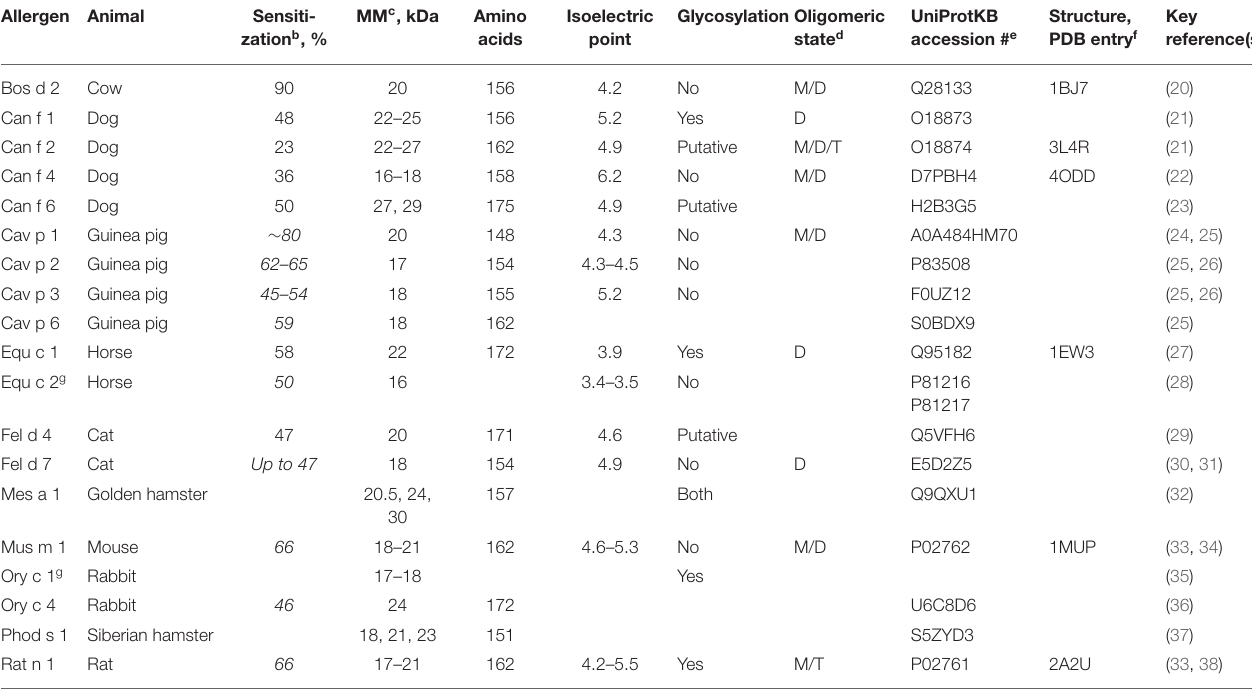
TABLE 1 | Physicochemical characteristics and sensitization rates of mammal-derived inhalant lipocalin allergens a . Allergen Animal Sensiti- zation b ,